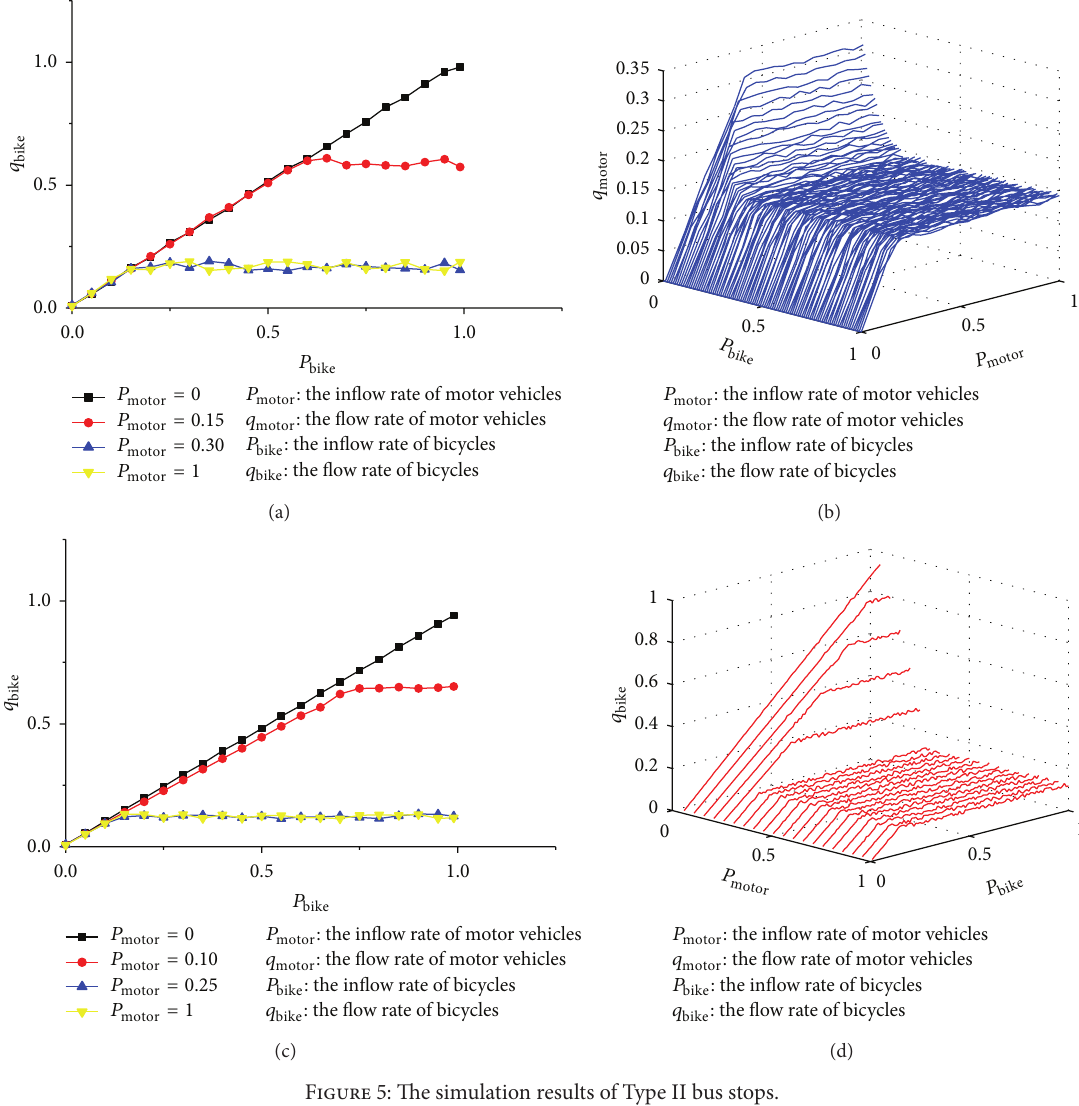
Figure 5: The simulation results of Type II bus